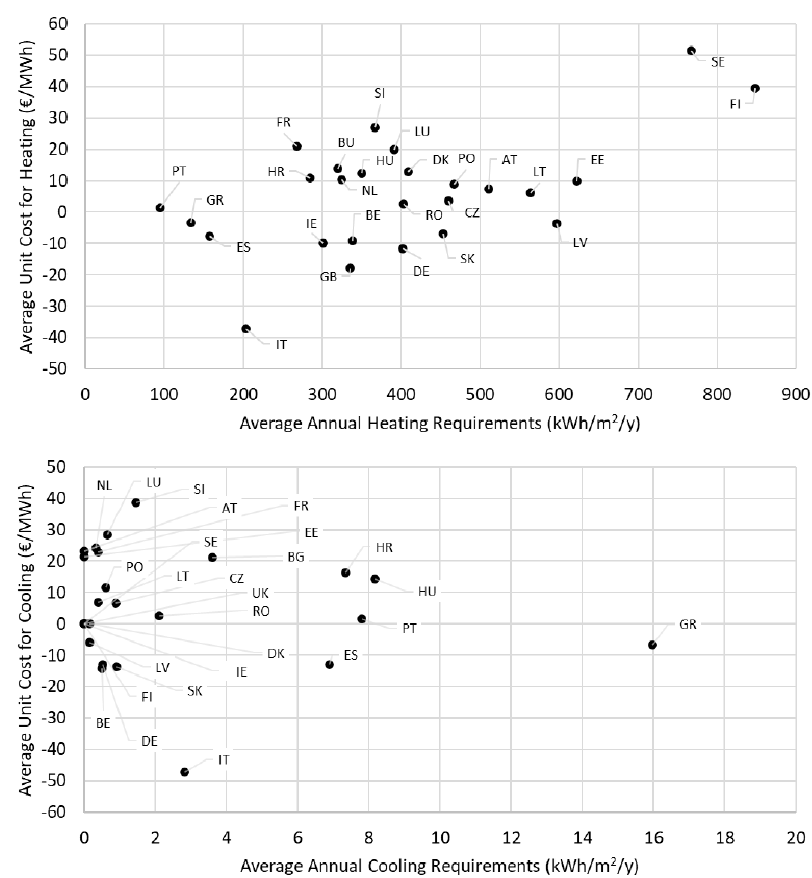
Figure 6. Average annual total cost for heating and cooling per unit area with CCHP (average annual values during the 2008–2018 period).